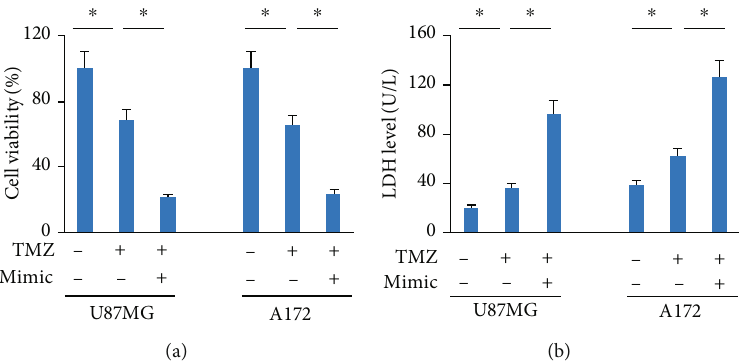
Figure 5: The miR-147a mimic sensitizes human glioblastoma cells to TMZ therapy. (a) Cell viability detected by CCK-8 assay. (b) LDH level in the medium from the miR-147a mimic-treated cells with or without TMZ stimulation. N = 6 for each group. Data were expressed as the mean ± SD , and P < 0 : 05 was considered statistically signi fi